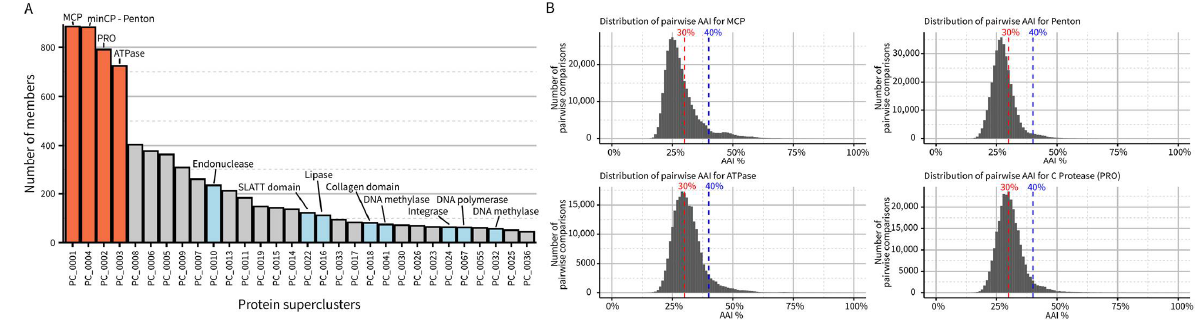
Figure 2. Genetic diversity in virophage genomes. ( A ) Size distribution and functional annotation of the 30 largest protein clusters obtained from the virophage sequences. The four conserved genes are colored in orange, while other protein clusters functionally annotated are colored in blue. ( B ) Distribution of pairwise amino-acid identity (AAI) across all virophage sequences for the four conserved morphogenesis genes. Two standard AAI cutoffs (30% and 40% AAI) are highlighted in red and blue, respectively. MCP: Major Capsid Protein (hexon). Penton: minor capsid protein.